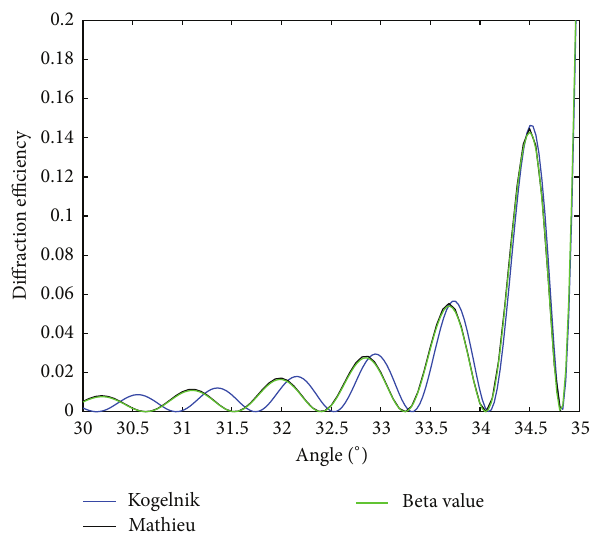
Figure 6: Diffraction efficiency of a reflection grating index- matched with thickness of 26 𝜇 m, spatial frequency of 3800 lines/mm, average refractive index 𝑛 index modulation of 0.012.